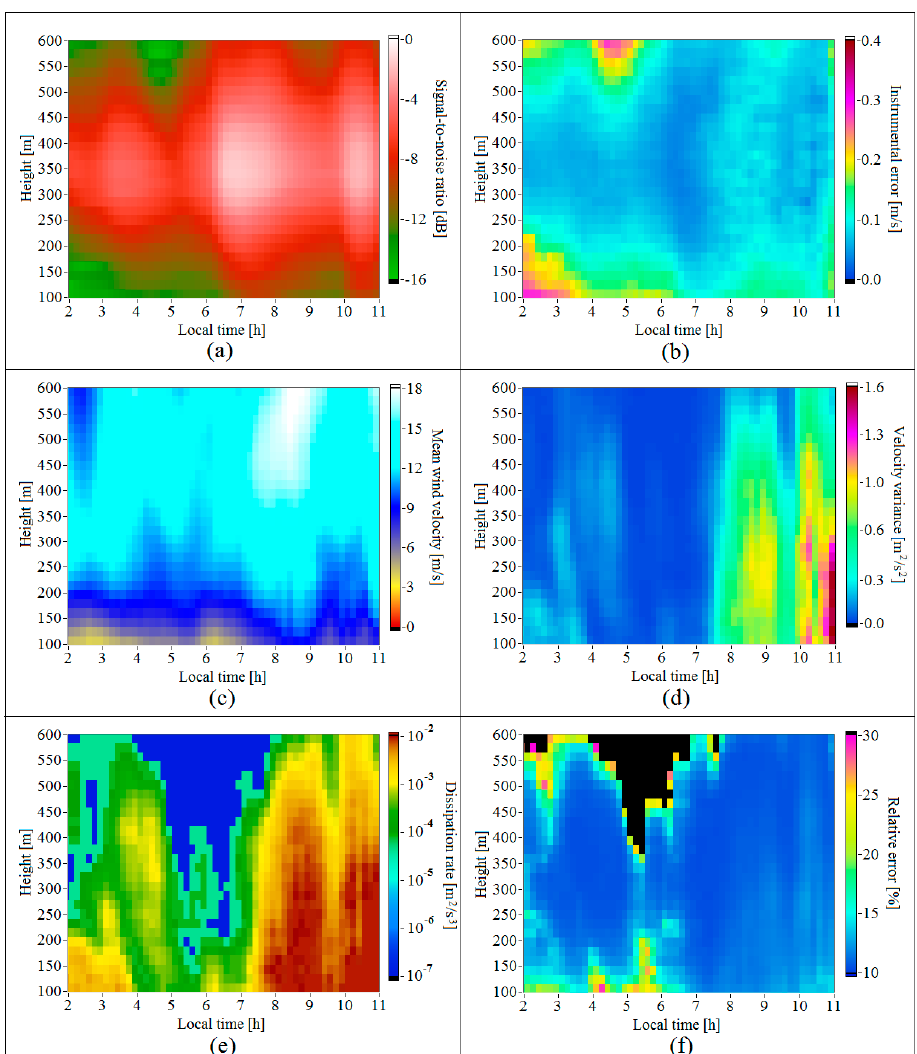
Figure 4. Height–temporal distributions of the signal-to-noise ratio ( a ), instrumental error of estimation of the radial velocity ( b ), mean wind velocity ( c ), variance of the vertical component of wind velocity vector ( d ), turbulent energy dissipation rate ( e ), and relative error of lidar estimation of the dissipation rate ( f ) as determined from data on 28 June 2020.